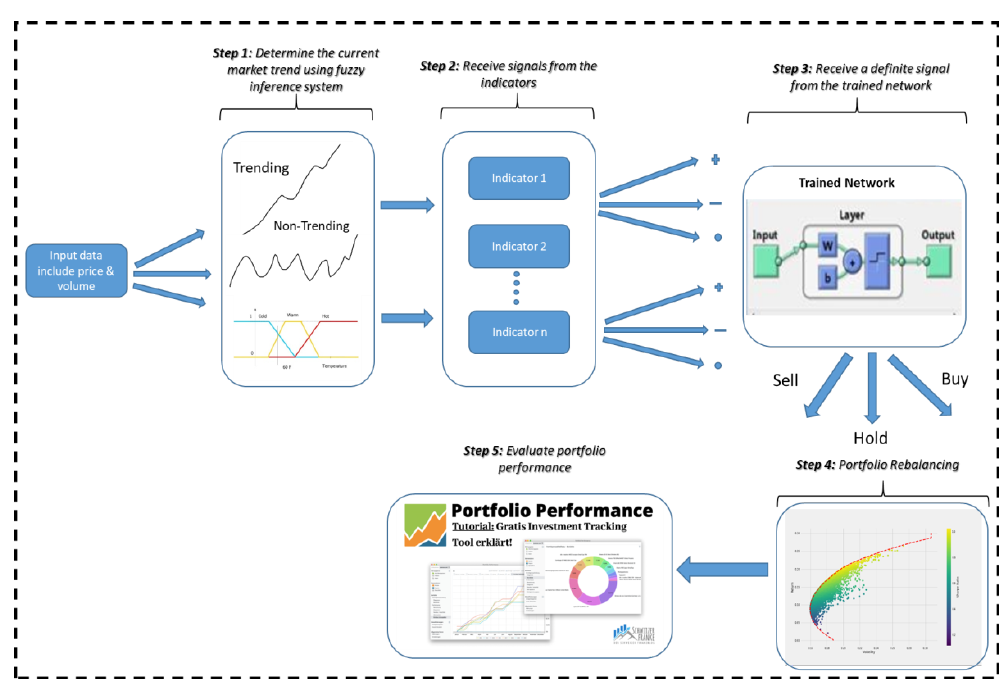
Figure 2. The second section includes implementation and